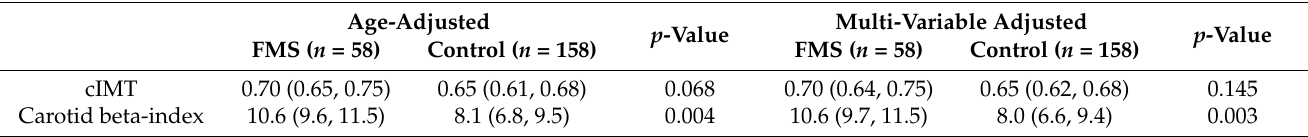
Table 3. Cardiometabolic profiles among female fibromyalgia syndrome (FMS) compared with those without FMS.